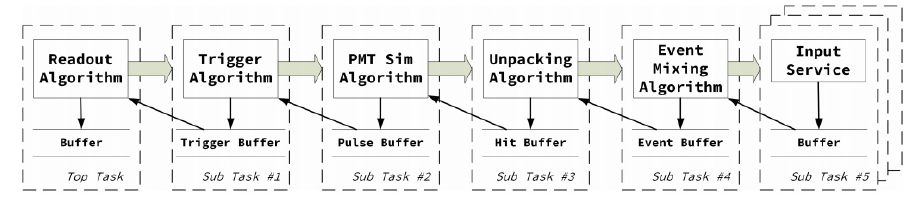
Fig.7. Workflow of electronics simulation.